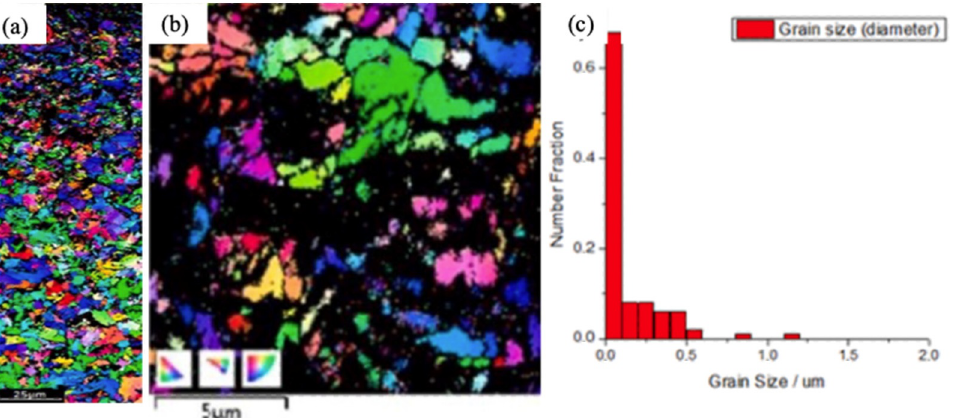
Figure 7. UNSM-treated S500 MC steel substrate: ( a , b ) EBSD of the cross-sections at two different magnifications, ( c ) grain-size distribution at the top layer. Reprinted with permission from ref. [97]. Copyright 2021, Elsevier.